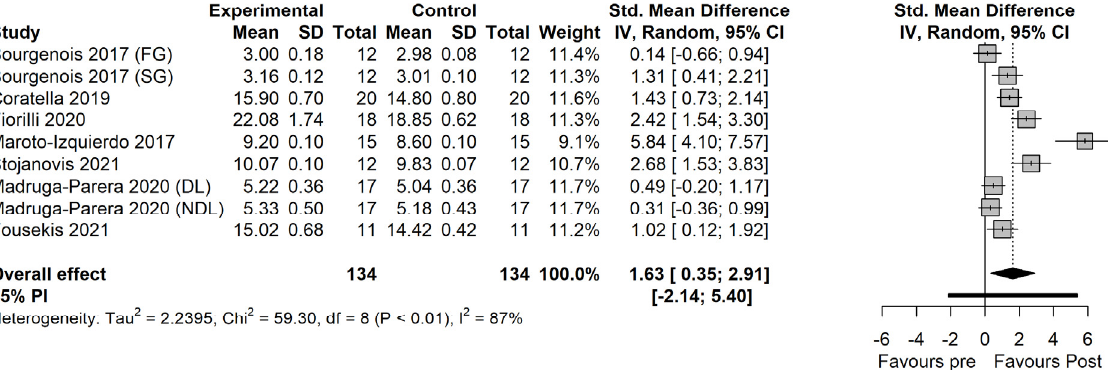
Figure 4. The effects of flywheel resistance training on change of direction performance in male athletes [22–28]. FG: fast group; SG: slow group; DL: dominant leg; NDL: non-dominant leg; RL: right leg.